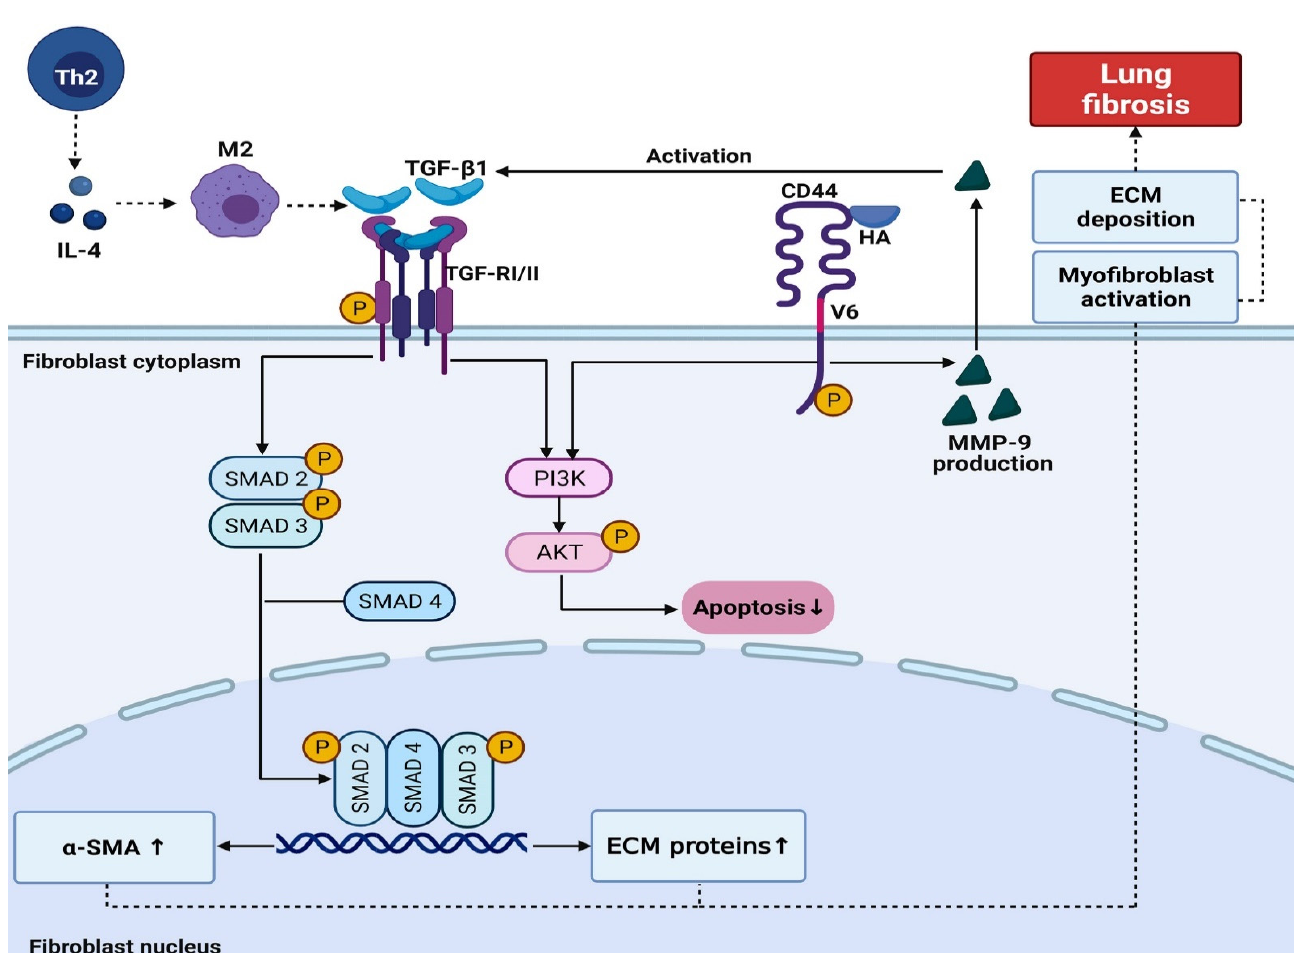
Figure 5. IL-4 mediates the functions of Th2 cells. IL-4 induces the alternative activation of M2 macrophages, which, in turn, secrete TGF- β 1, stimulating fibroblast proliferation. The TGF- β type I and type II receptors (TGFRI and II) activate several intracellular signaling cascades, including the canonical SMAD2/3-4 and the noncanonical PI3K/AKT pathways. Once active, TGFRI triggers the complex SMAD2/3-4 that binds profibrotic genes and induces fibrogenic proteins expression such as α -SMA and Collagen I (mature), resulting in induction myofibroblast activation and ECM deposition. The PI3K/AKT pathway, on the other hand, increases the resistance of fibroblasts and the proliferation of myofibroblasts. Furthermore, once the CD44v6/HA complex is formed, the PI3K/AKT pathway leads to fibroblasts’ resistance to apoptosis. This CD44v6/HA interaction increases the production of MMP-9, which leads to the activation of TGF- β 1.